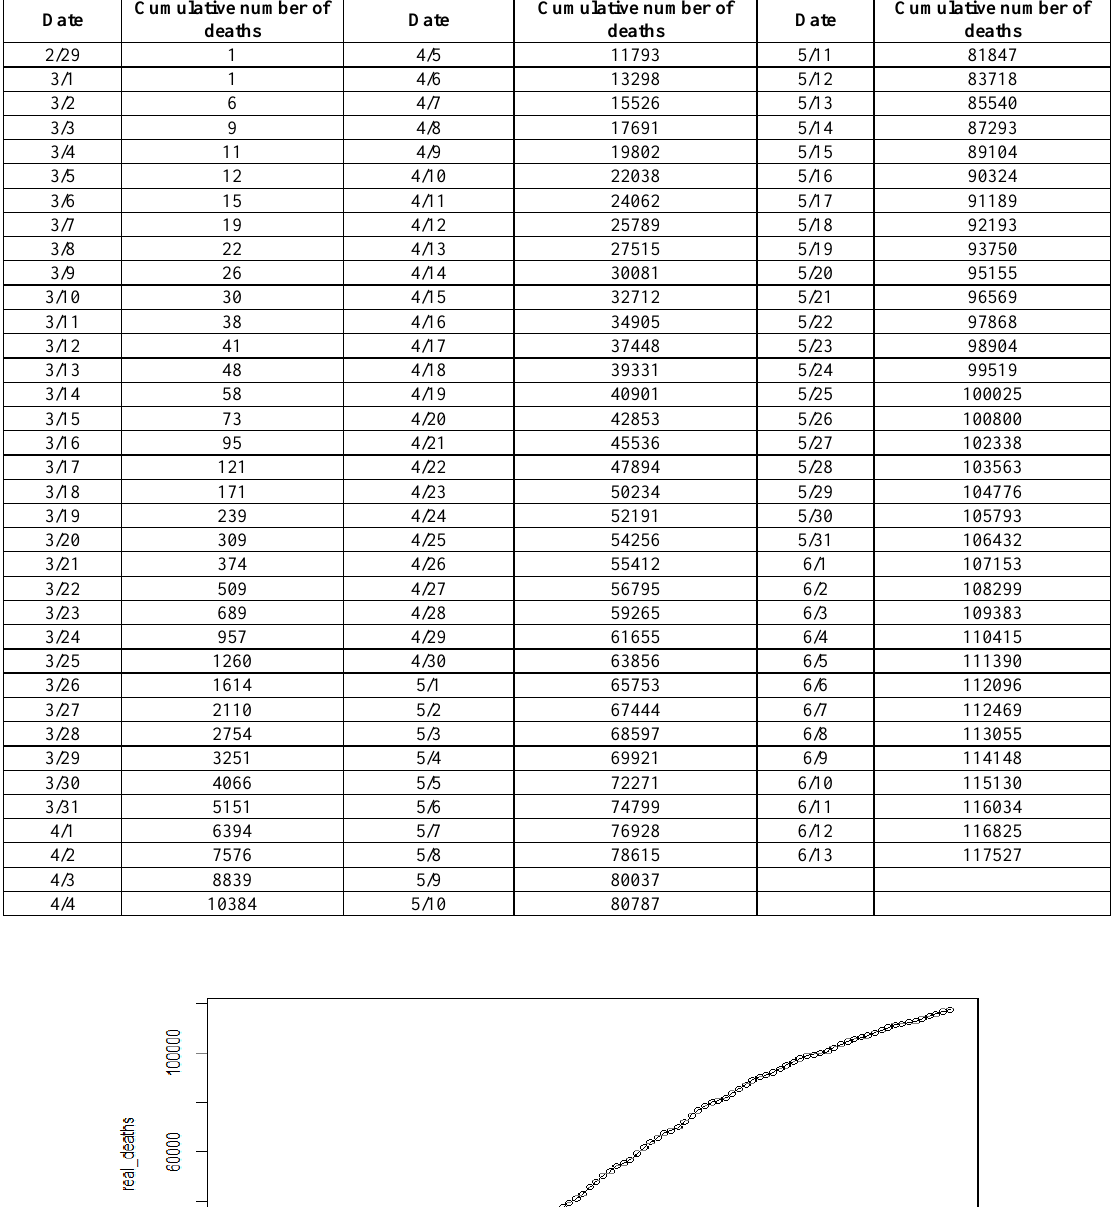
Table 2. US Deaths data (Worldometers, 2020) during 2/29/20 - 6/13/20